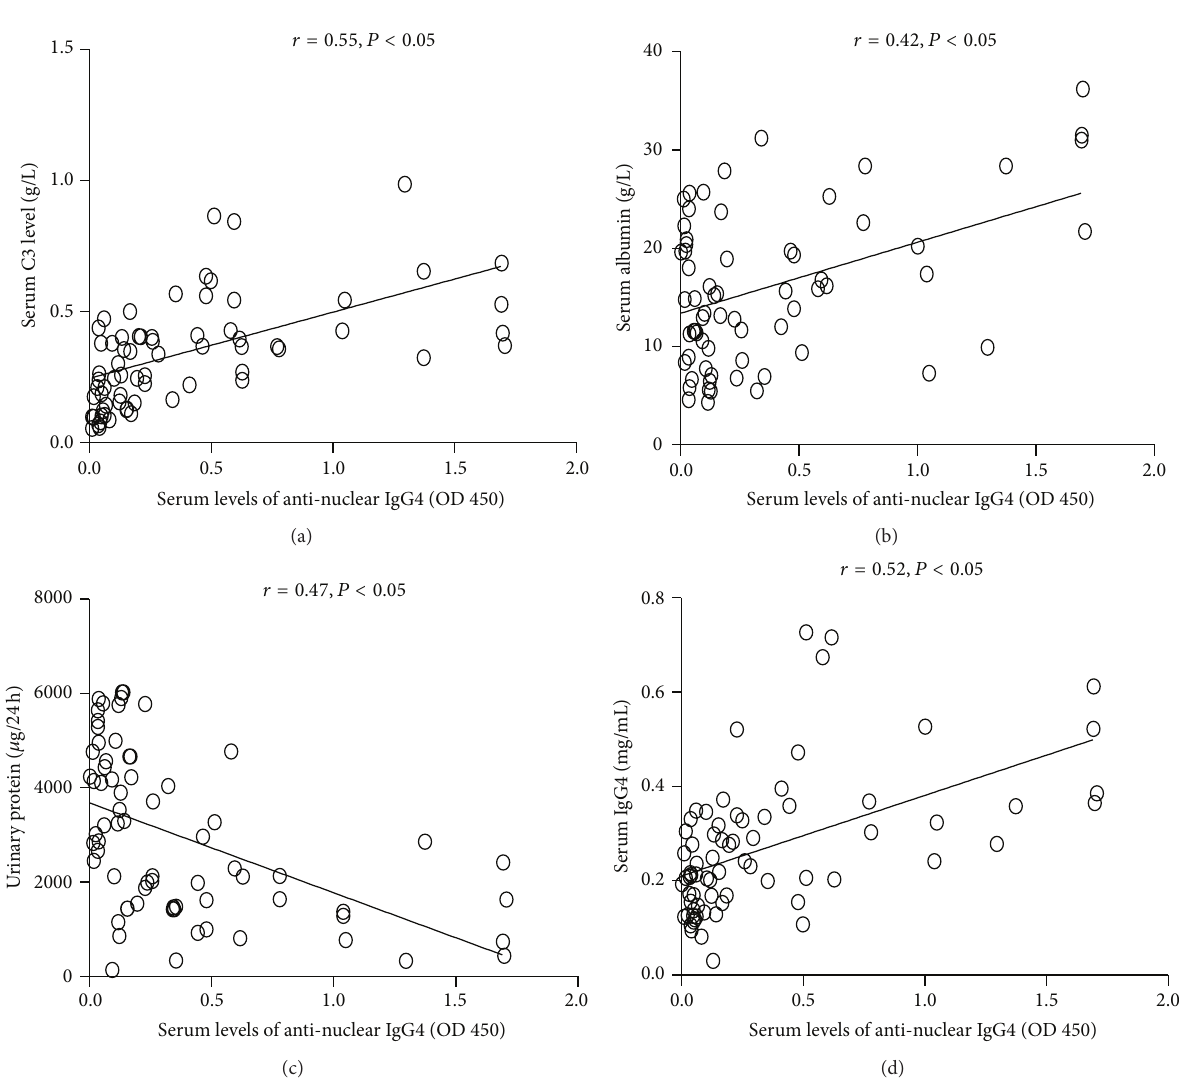
were blindly examined by two pathologists, and ambiguous samples were reviewed to achieve a